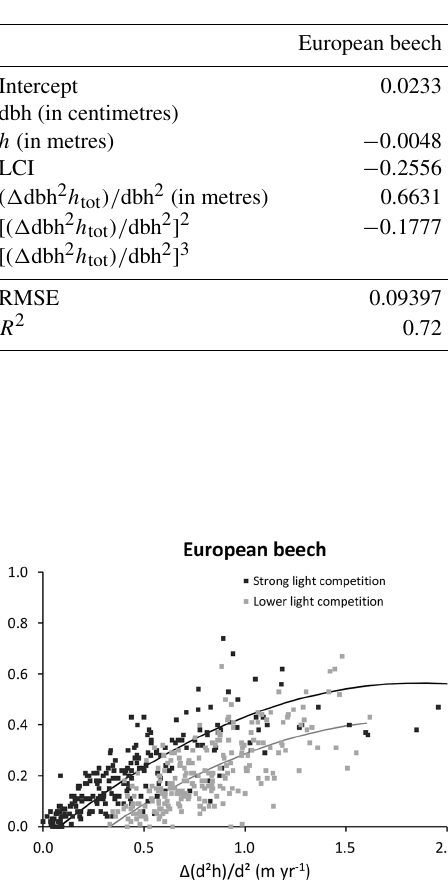
Table E1. Parameters, R 2 and RMSE of the height growth model (Eq. 31) for European beech and sessile